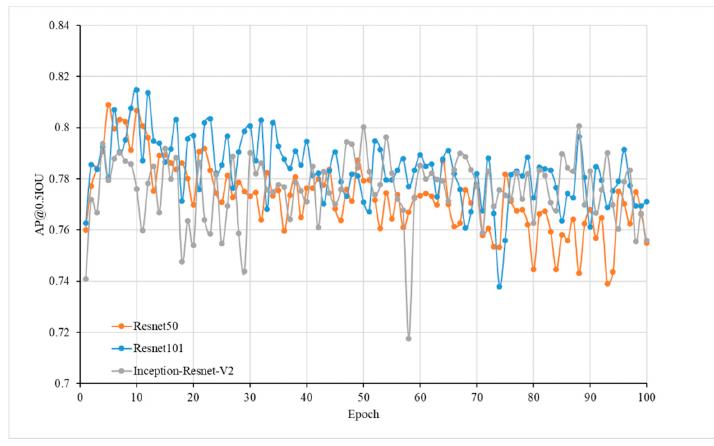
Figure 3. Accuracy of the tomato detection model.